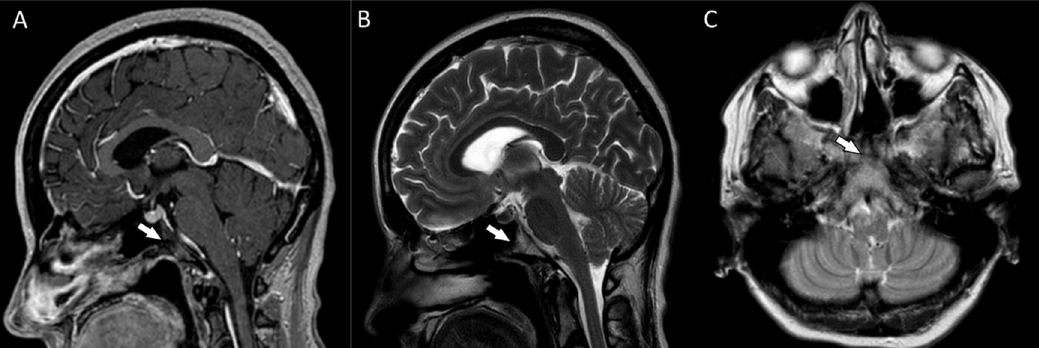
Figure 4. ( A , B ) The postoperative magnetic resonance T1-weighted and T2-weighted sagittal images and the postoperative magnetic resonance T2-weighted coronal image ( C ) showing some minimal residual lesions within the clival region (arrows) .